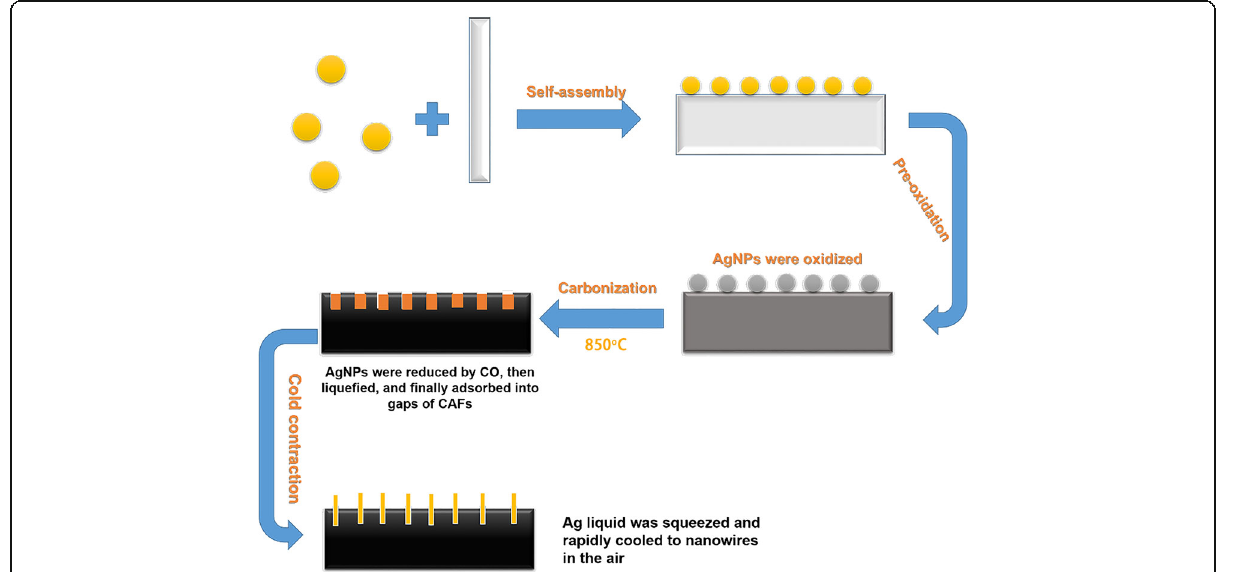
Fig. 5 Schematic diagram for fabrication of Ag nanohair-grown ACFs